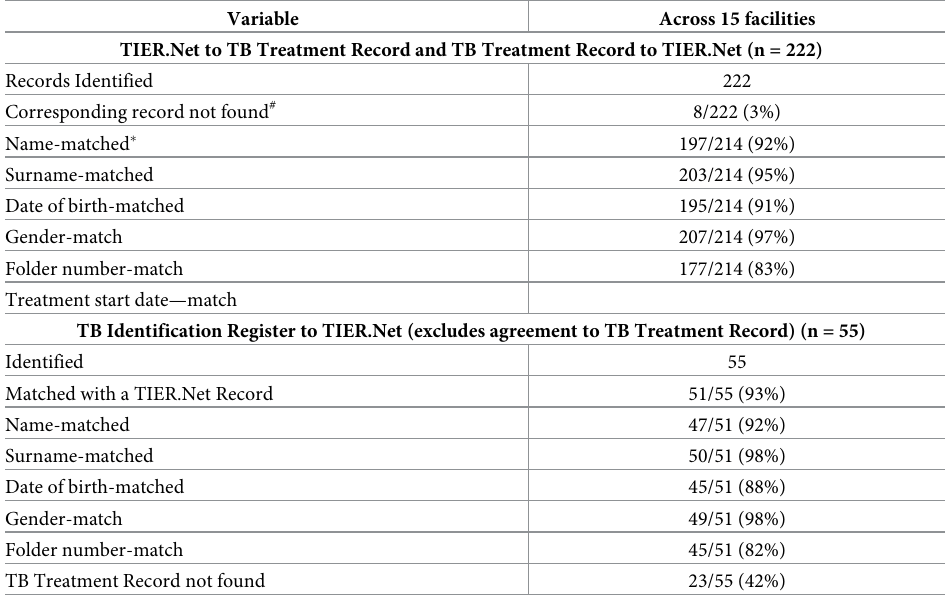
Table 3. Accuracy of demographic information, by source of information (n =